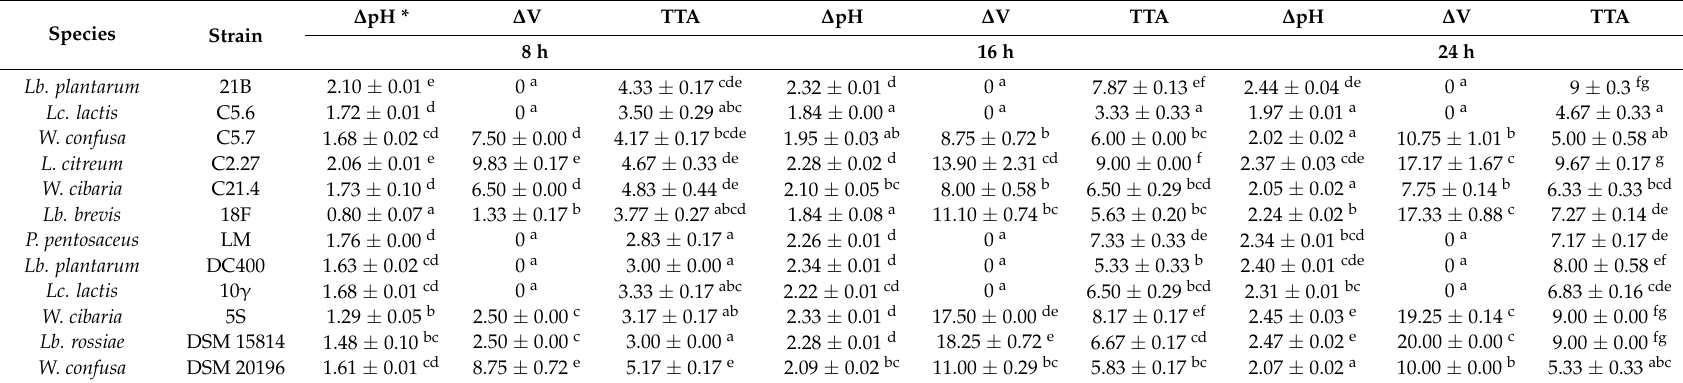
Data represent means of three independent experiments ± standard error. a–g Values in the same column with different letters differ significantly ( p < 0.05). * The initial pH of the doughs was 6.04 ± 0.22. Lb. , Lactobacillus ; L. , Leuconostoc ; Lc. , Lactococcus ; W. , Weissella ; P. , Pediococcus